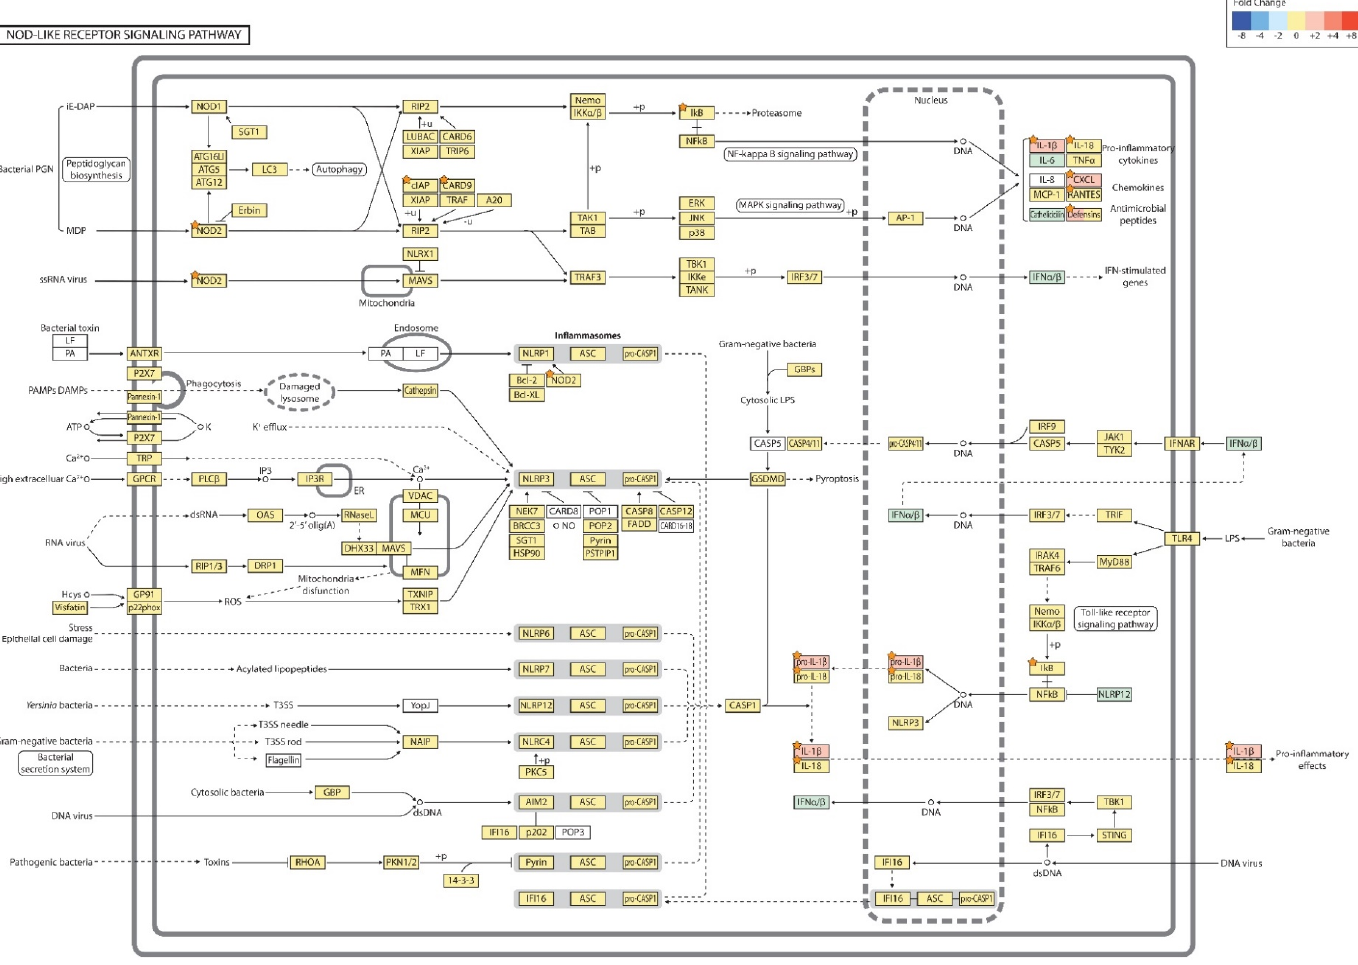
Figure 7. Nodulation (NOD)-like receptor signaling pathway (PM vs. control). The orange star signifies genes with a p < 0.05. + p: phosphorylation; + u: ubiquitination; − u: de-ubiquitination; - - ->: activation.